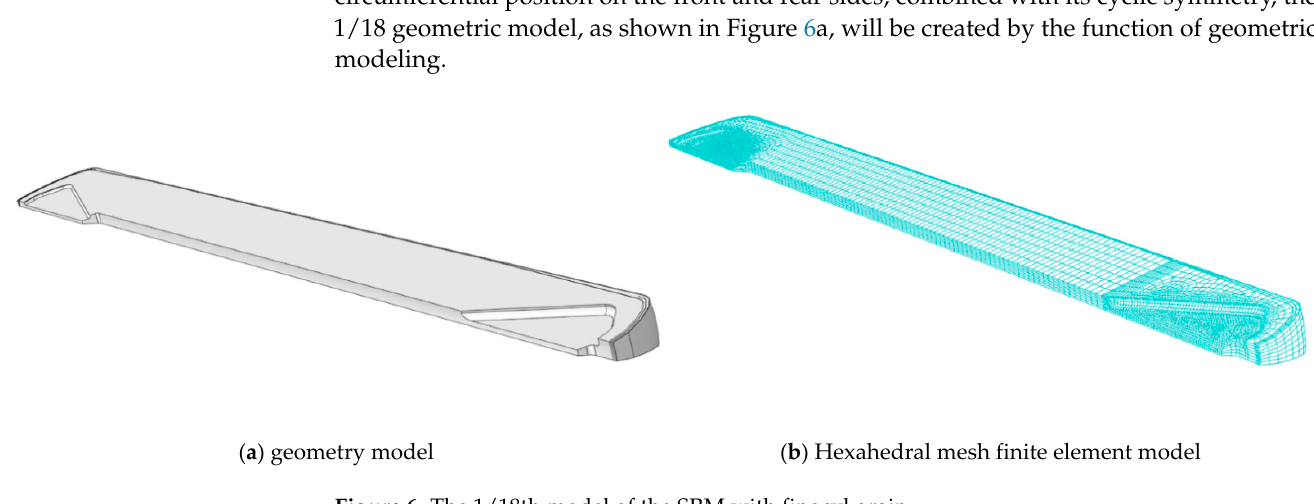
Figure 6. The 1/18th model of the SRM with finocyl grain.